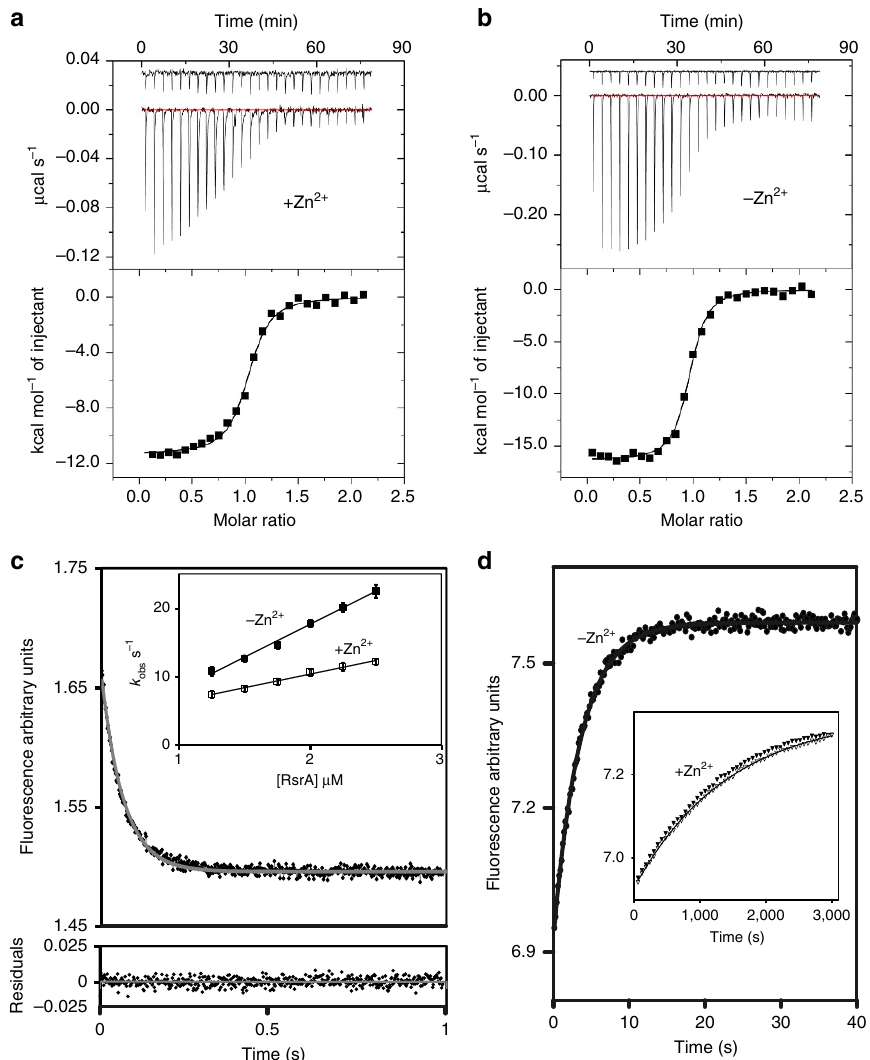
Figure 3 | Zinc slows the dissociation rate of the high-affinity RsrA red .Zn 2 þ - r R complex. Conditions used for all experiments were 50mM Tris (pH 7.5) buffer containing 100mM NaCl and 2mM DTT. Temperature was either 35 (cid:2) C ( a , b ) or 25 (cid:2) C ( c , d ). ( a ) Competition ITC data for RsrA red .Zn 2 þ (100 m M) binding s R (10 m M, cell concentration) in the presence of RsrA* Cys11Ser Cys44Ser (50 m M). RsrA* Cys11Ser Cys44Ser binds s R with a weaker affinity than wild-type RsrA (Supplementary Table 1). Control data show titration of RsrA red .Zn 2 þ into buffer containing 50 m M RsrA* Cys11Ser Cys44Ser. Fitted parameters for a competitive binding site model from three independent measurements were N ¼ 1.01 ± 0.05, K d ¼ 0.78 ± 0.034nM, D H ¼ (cid:2) 23.05 ± 1.10kcalmol (cid:2) 1 , D S ¼ (cid:2) 38.70 ± 3.10calmol (cid:2) 1 deg (cid:2) 1 . ( b ) Direct ITC data for RsrA red (100 m M) binding s R (10 m M) in the absence of zinc. Control data show titration of RsrA red into buffer. Fitted parameters for a single site-binding model were N ¼ 0.97 ± 0.004, K d ¼ 79.3 ± 4.2nM, D H ¼ (cid:2) 16.26 ± 0.13kcalmol (cid:2) 1 , D S ¼ (cid:2) 20.3 ± 4.34calmol (cid:2) 1 deg (cid:2) 1 . ( c ) Main panel: tryptophan emission fluorescence stopped-flow association data for RsrA red .Zn 2 þ binding s R under pseudo-first-order conditions ( l ex , 295nm). Residuals to the fit of a single exponential are shown below the panel. Inset: pseudo-first-order plot of observed rates ( k obs ) as a function of RsrA concentration in the presence and absence of stoichiometric zinc (with associated error bars). See Supplementary Table 2 for derived values of k on . Error bars are within the data point symbols. ( d ) Dissociation of the RsrA red – s R complex measured by competition stopped-flow in which a 10-fold excess of s R Trp88Ile Trp119Ile was used to displace wild-type s R (Methods). Main panel shows data for the RsrA red – s R complex in the absence of bound zinc. Inset: dissociation data for the RsrA red – s R complex in the presence of 1 and 3equiv. of zinc (open and filled triangles, respectively). See Supplementary Table 2 for values of k off